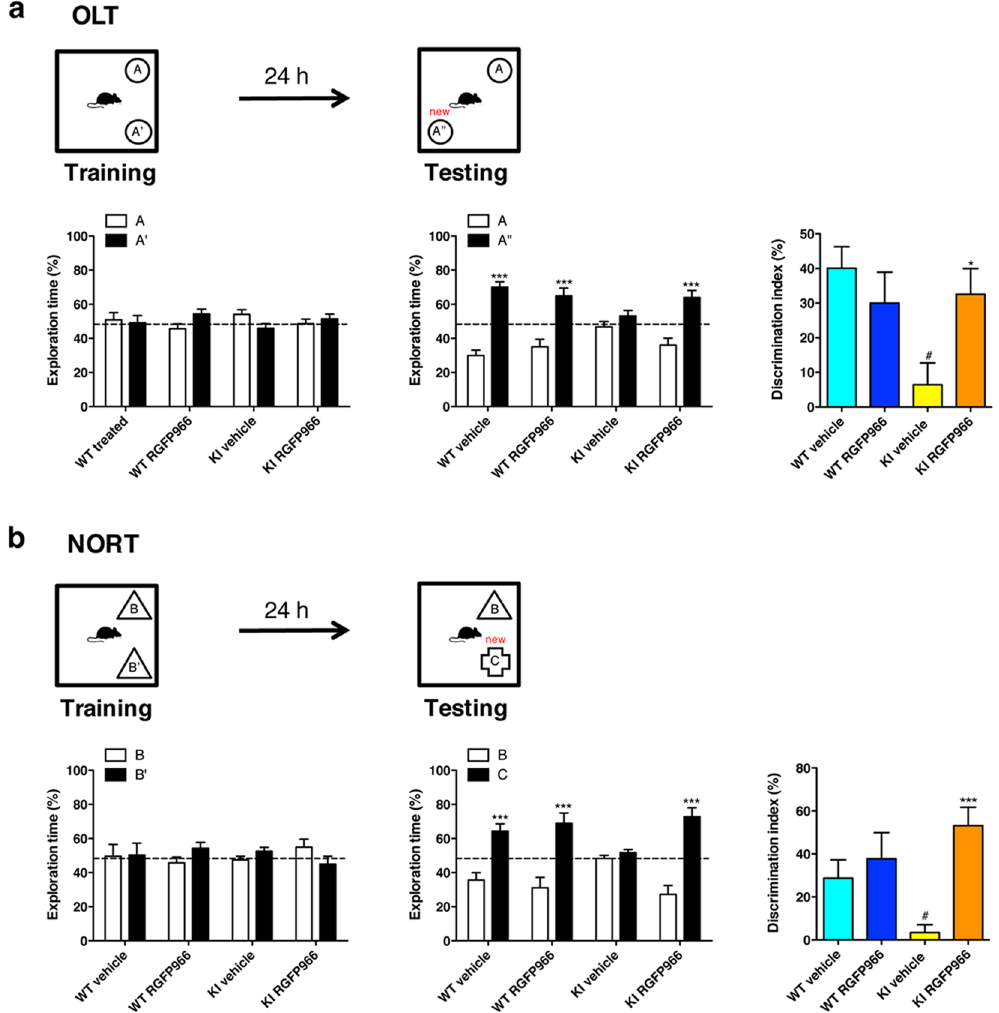
Figure 2. RGFP966 treatment prevents impairment of long-term memory in HD mice. Behavior analysis in vehicle and RGFP966 chronically treated Hdh Q7/Q7 (WT) and Hdh Q7/Q111 (KI) mice. Performance in (a) spatial (OLT) and (b) recognition (NORT) memory tests. Exploration time during training and testing session (left and center panels). Dashed line shows chance level for exploration. *** p < 0.001 compared to the percentage of time exploring the familiar object by two-way ANOVA with Bonferroni post-hoc analysis. Discrimination index (right panel). * p < 0.05, *** p < 0.001 compared to vehicle-treated KI mice; # p < 0.05 compared to vehicle- treated WT mice by two-way ANOVA with Bonferroni post-hoc analysis. Data represent the mean ± SEM (n = 5–9 animals per